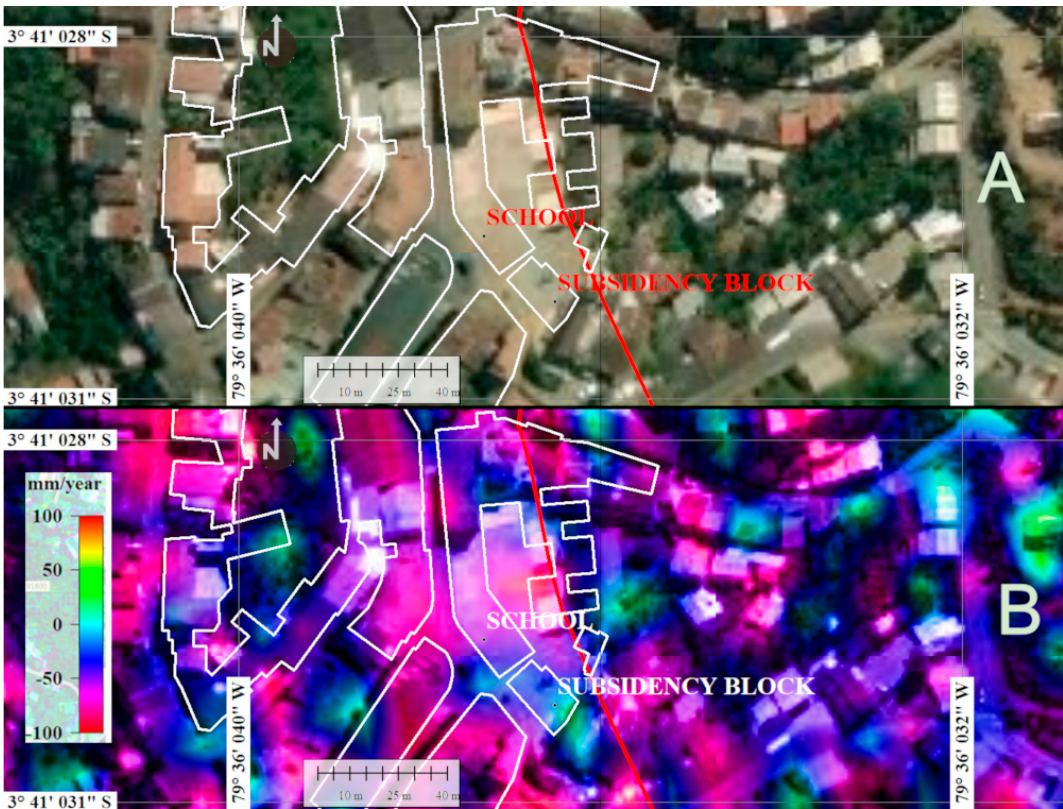
Figure 9. ( A ) Location of Fe y Alegría-La Immaculada School in the study area before the collapse of the block of school classrooms. ( B ) Block collapse of school classrooms on October 25 of a day before the collapse that began on October 16, 2016, and completely collapsed in December 2016. The faint blue color indicates that before October 25, 2016 the sinking of the area was in process. Gallery is in red color and blocks houses are in white color.